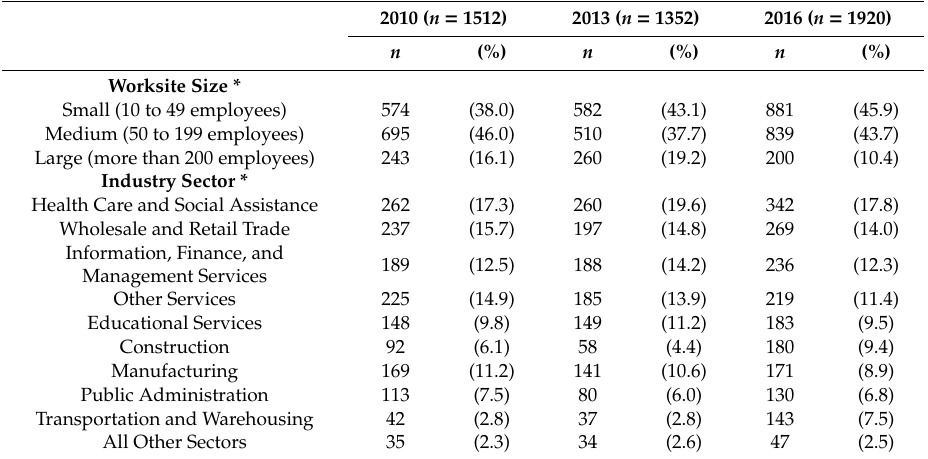
Table 1. Participating worksites by size and industry sector by year (2010, 2013, and 2016).